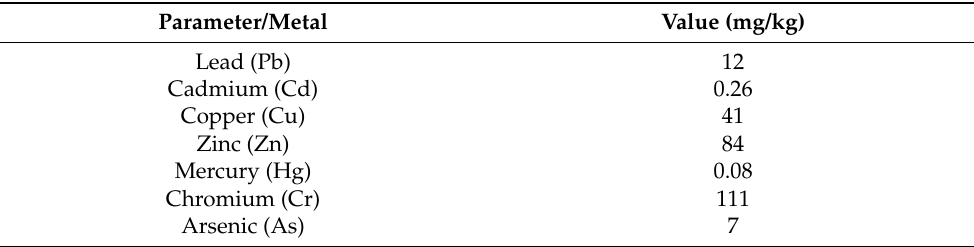
Table 4. Results of metal analysis in the sediment of Skadar Lake (near the settlement Vranjina). Parameter/Metal Value (mg/kg)